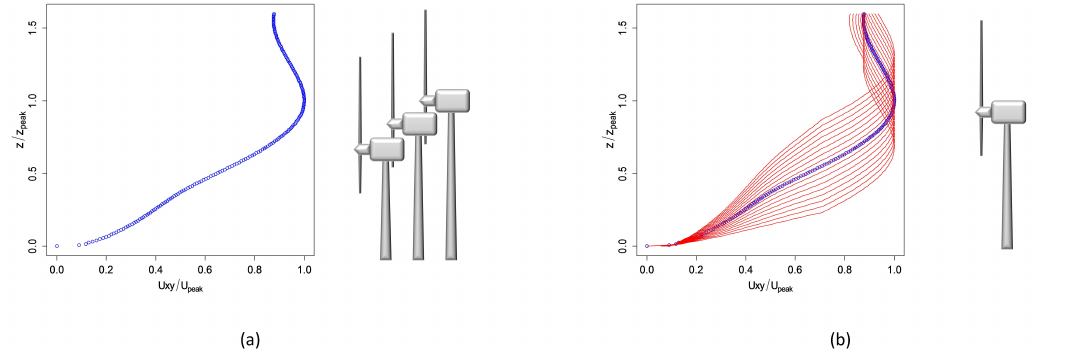
Figure 1. Methods to generate values of the parameter ξ . In the first method (a) a single wind data grid was combined with the turbine simulated at several heights. In the second method (b) the turbine at a single height was combined with a family of synthetic data grids (represented by red lines) generated after the original jet data (in blue